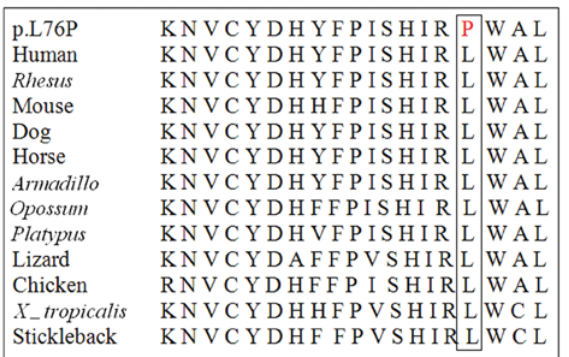
Figure 2. Alignment analysis of the p.L76P mutation in the connexin 26, GJB2 gene, in different species. Residue 76 is boxed.